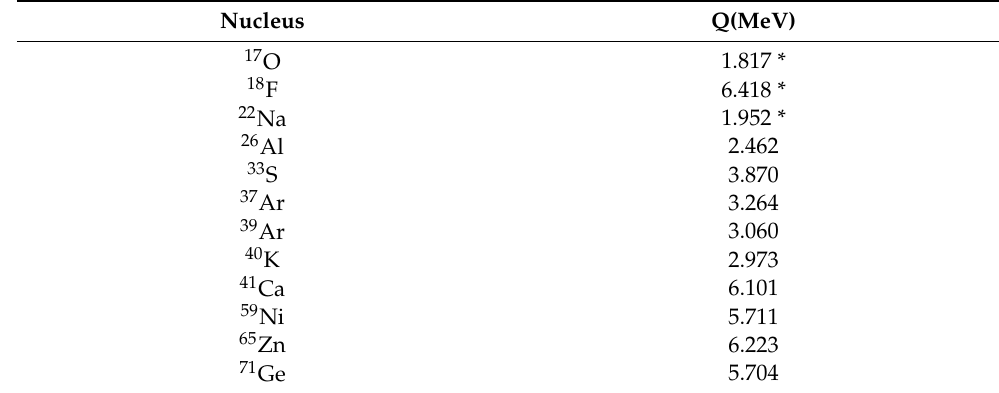
Table 1. Q-values for ( n , α ) reactions used in this work, obtained from Skyrme HFB-17 interaction [52], except for nuclei denoted with * where the experimental Q-values are adopted